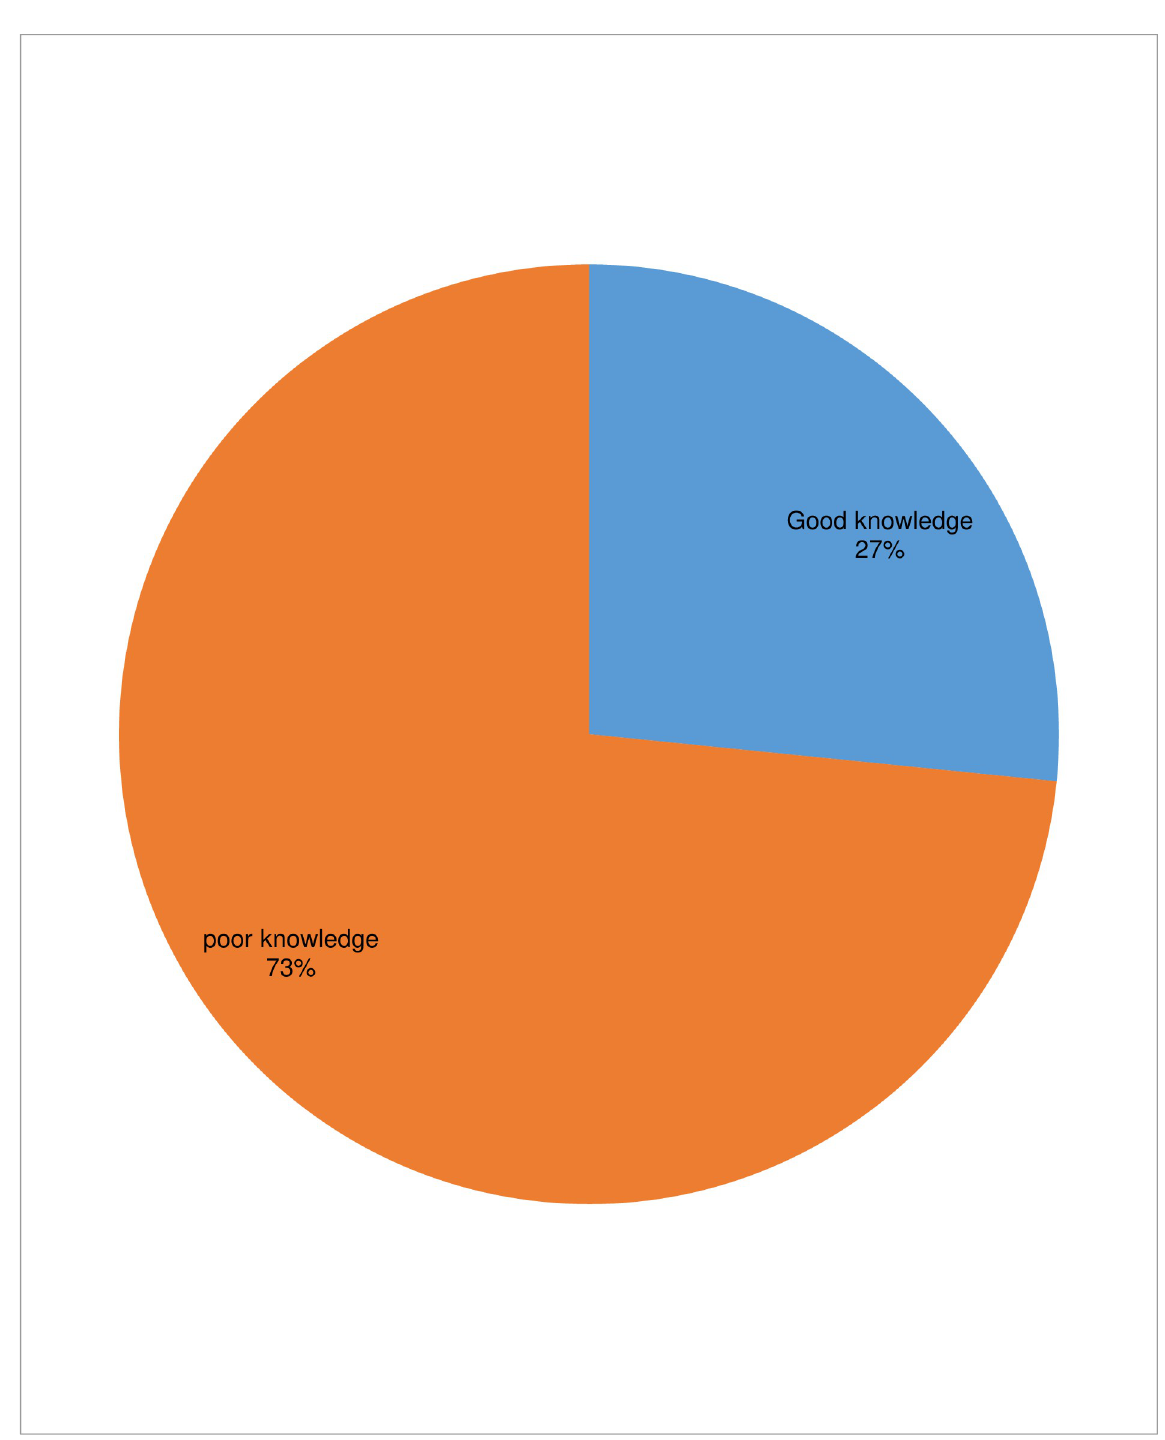
Fig 1. Knowledge of preconception care among reproductive age women in Miza Aman town, Bench-Sheko Zone, Southwest Ethiopia, 2020 (n = 605).